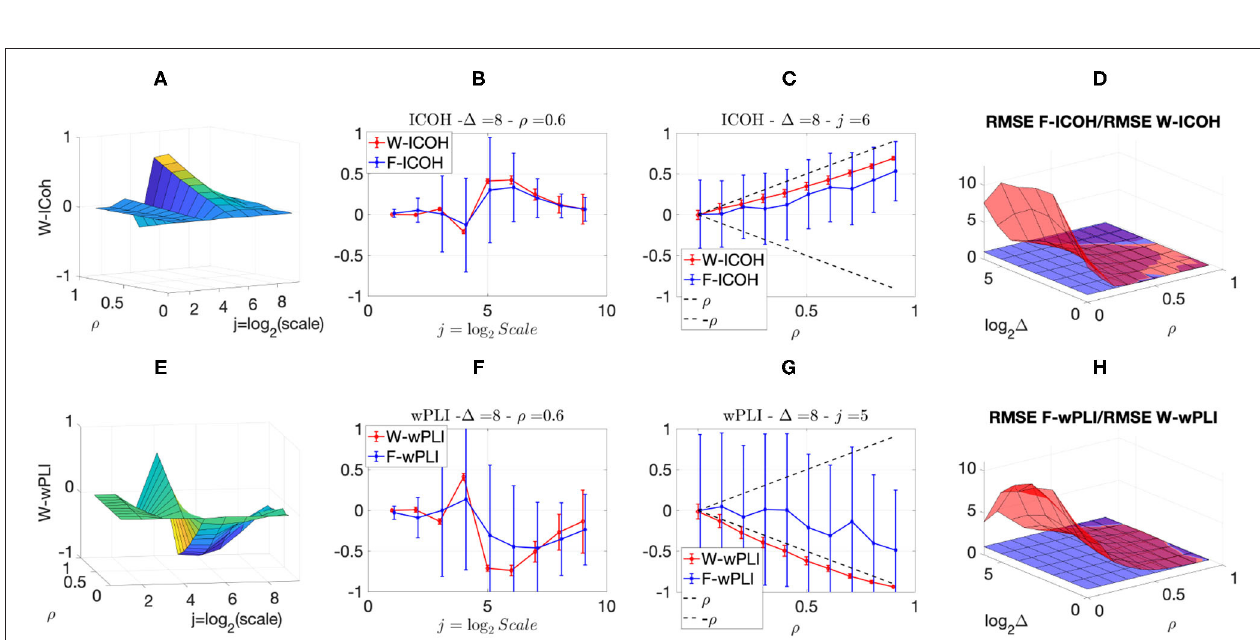
FIGURE 4 | Complex Wavelet-based connectivity on synthetic bivariate fractional Brownian motion with correlation and delay 1 = 8. Top row: W-ICOH results. Bottom row: W-wPLI results. From left to right: W-ICOH (A) and W-wPLI (E) as functions of octaves j and correlation coefficient ρ ; W-ICOH (B) and W-wPLI (F) as functions of octaves j , for a given ρ ; W-ICOH (C) and W-wPLI (G) as functions of ρ for given octaves j ; Ratio of the RMSE of F-ICOH to the RMSE of W-ICOH (D) and ratio of the RMSE of F-wPLI to the RMSE of W-wPLI (H) , averaged across scales 3 ≤ j ≤ 7, and color-coded in red as functions of delay 1 and correlation coefficient ρ . A ratio greater than the value of 1 (made explicit to ease comparisons by horizontal blue plans) indicates poorer performance for Fourier-based estimates compared to wavelet-based ones. Synthetic data consists of bivariate fBm with H 1 = 0.7 and H 2 = 0.8.